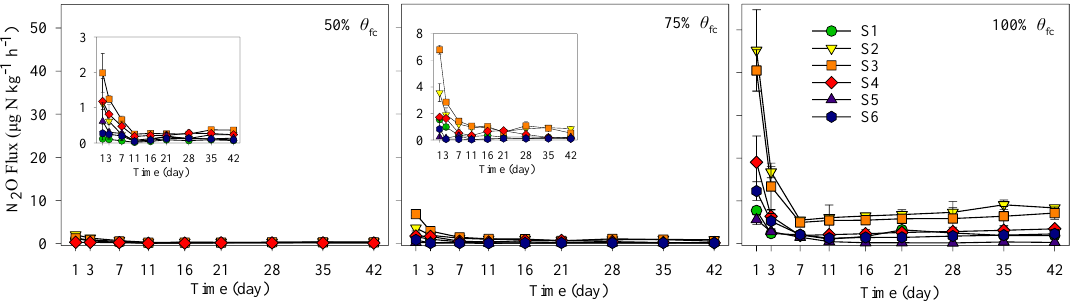
Figure 3. Fluxes of N 2 O emissions during the incubation period. S1, S2, S3, S4, S5 and S6 represent six levels of soil salinity (0.25, 1.01, 2.02, 3.21, 4.92 and 6.17 dS m −1 ), respectively. The inserts in 50% 𝜃 fc and 75% 𝜃 fc enlarge the ordinate to show differences more clearly. Error bars indicate standard error of mean ( n = 3).